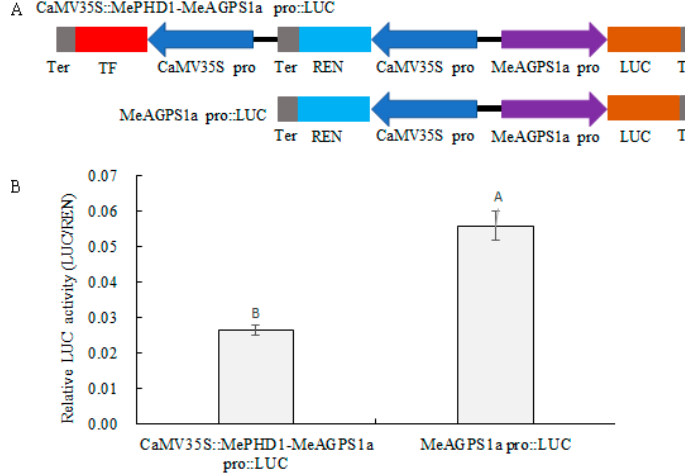
Figure 7. Repression of MeAGPS1a promoter, in the transient expression system, by MePHD1. ( A ) Schematic diagrams of the two transient expression vectors. ( B ) Relative LUC activity of vector pCaMV35S::MePHD1-MeAGPS1a Pro::LUC and pMeAGPS1a Pro::LUC, in tobacco leaves. Error bars represent the SD of nine technical replicates, the significant difference was assessed by ANOVA, A,B means the significant difference at p < 0.01 level. TF: Transcription factor; REN: Renilla luciferase; LUC: Luciferase; pro: MeAGPS1a promoter; Ter: Terminator.